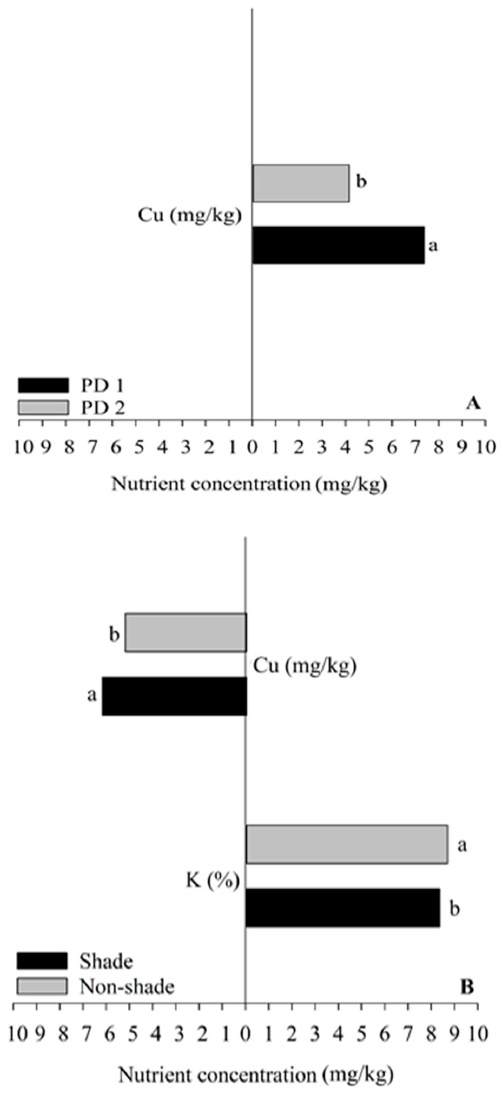
Figure 2. The main effects of two planting dates (PD) ( A ) and shade cloth ( B ) on the foliar concentrations of copper (Cu) and potassium (K) in high tunnel-grown lettuce. Columns followed by the same letter(s) are not significantly different according to Tukey’s Honest Significant Difference Test ( p < 0.05).